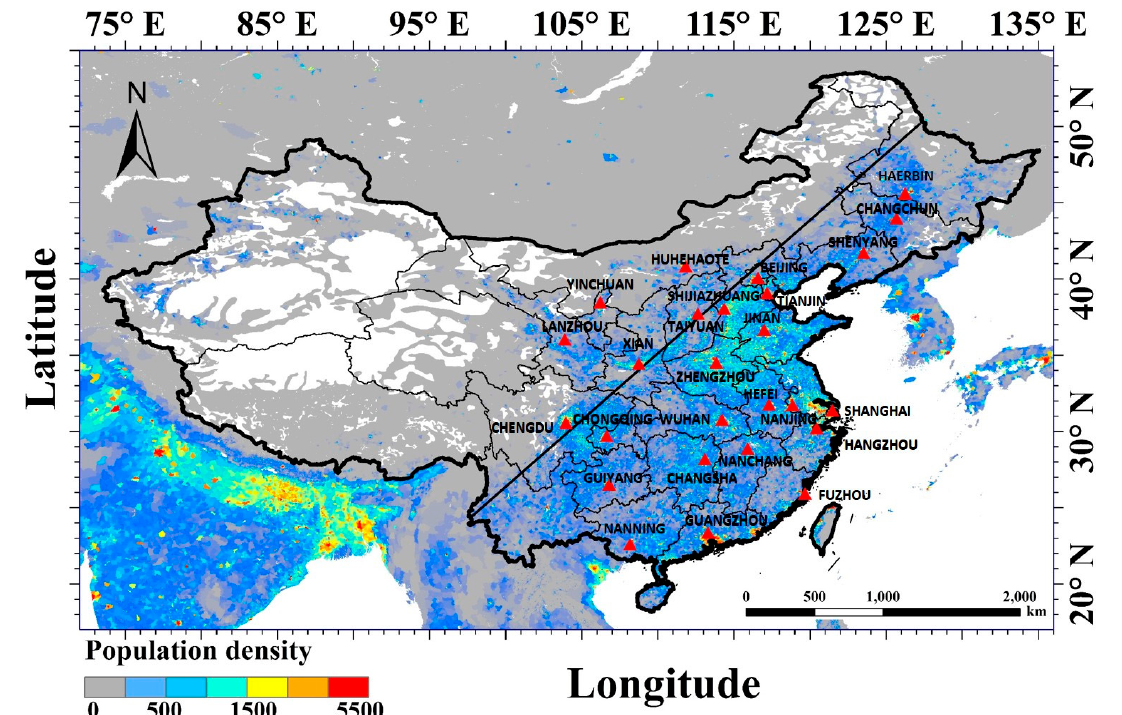
Figure 1. Population density (people per km 2 ) map for China with a total of 1.4005 billion people (http://sedac.ciesin.columbia.edu/data/collection/gpw-v4/sets/browse). The red triangles show the 26 provincial capitals which are used in this study for comparison with detailed results for Wuhan. The line is the HU Line, which divides China in eastern and western parts .